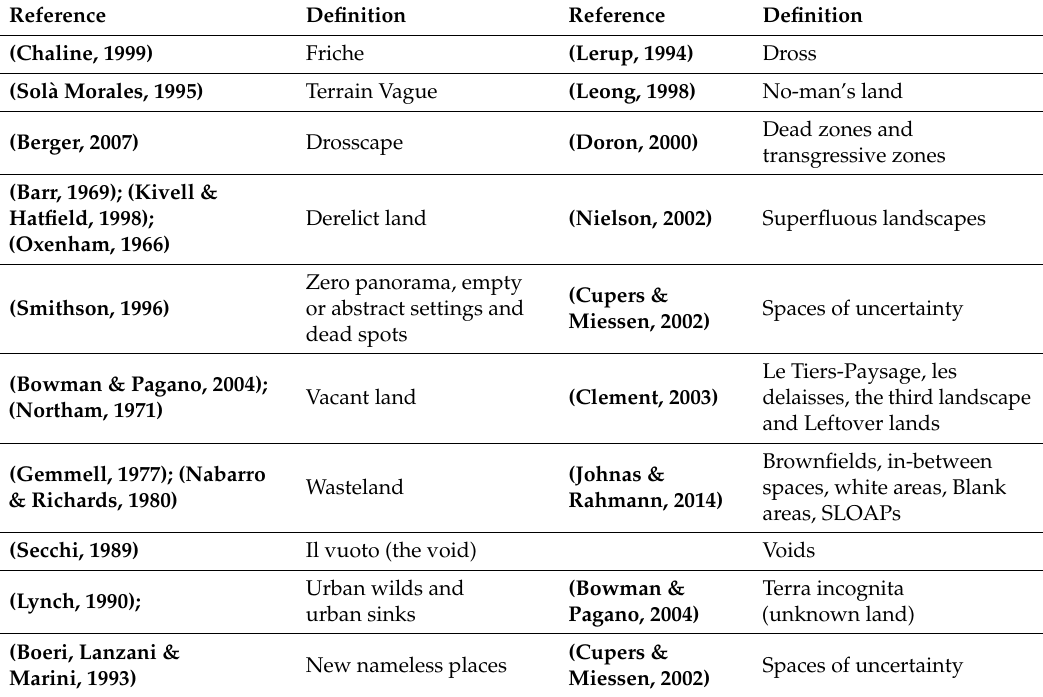
Table 2. Summary of the terms used to describe abandoned and residual